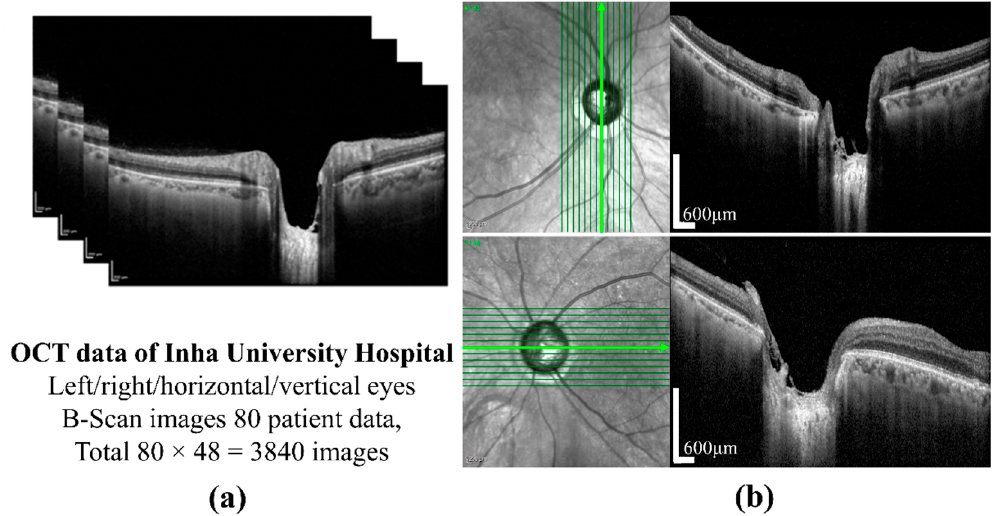
Figure 1. ( a ) OCT images from the Inha University Hospital; ( b ) an image was obtained by sampling near the optic nerve nipple. Scale bar: 600 µm.